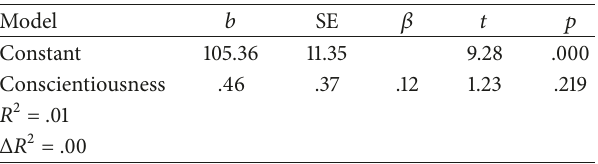
Table 9 summarized the six hypotheses and their results.